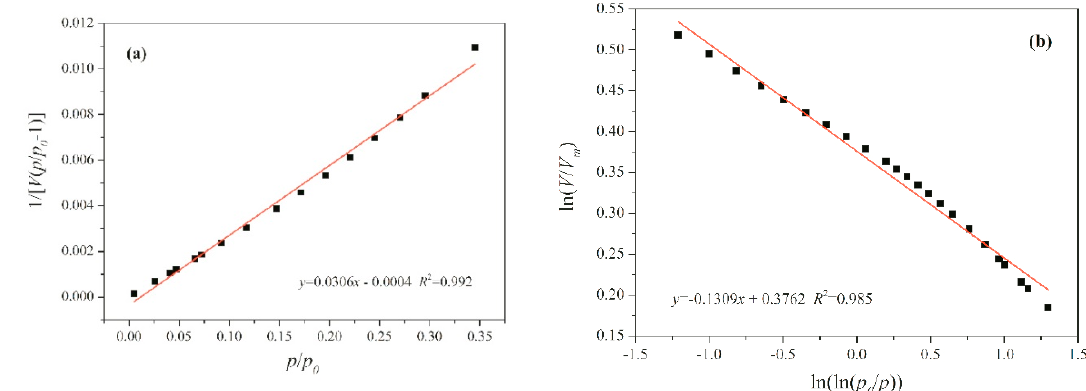
Figure 9. Fractal analysis of fresh 5Fe5Ce/ZSM-5: ( a ) fitting curve for nitrogen uptake of a monolayer coverage and ( b ) fitting curve for surface fractal dimension.